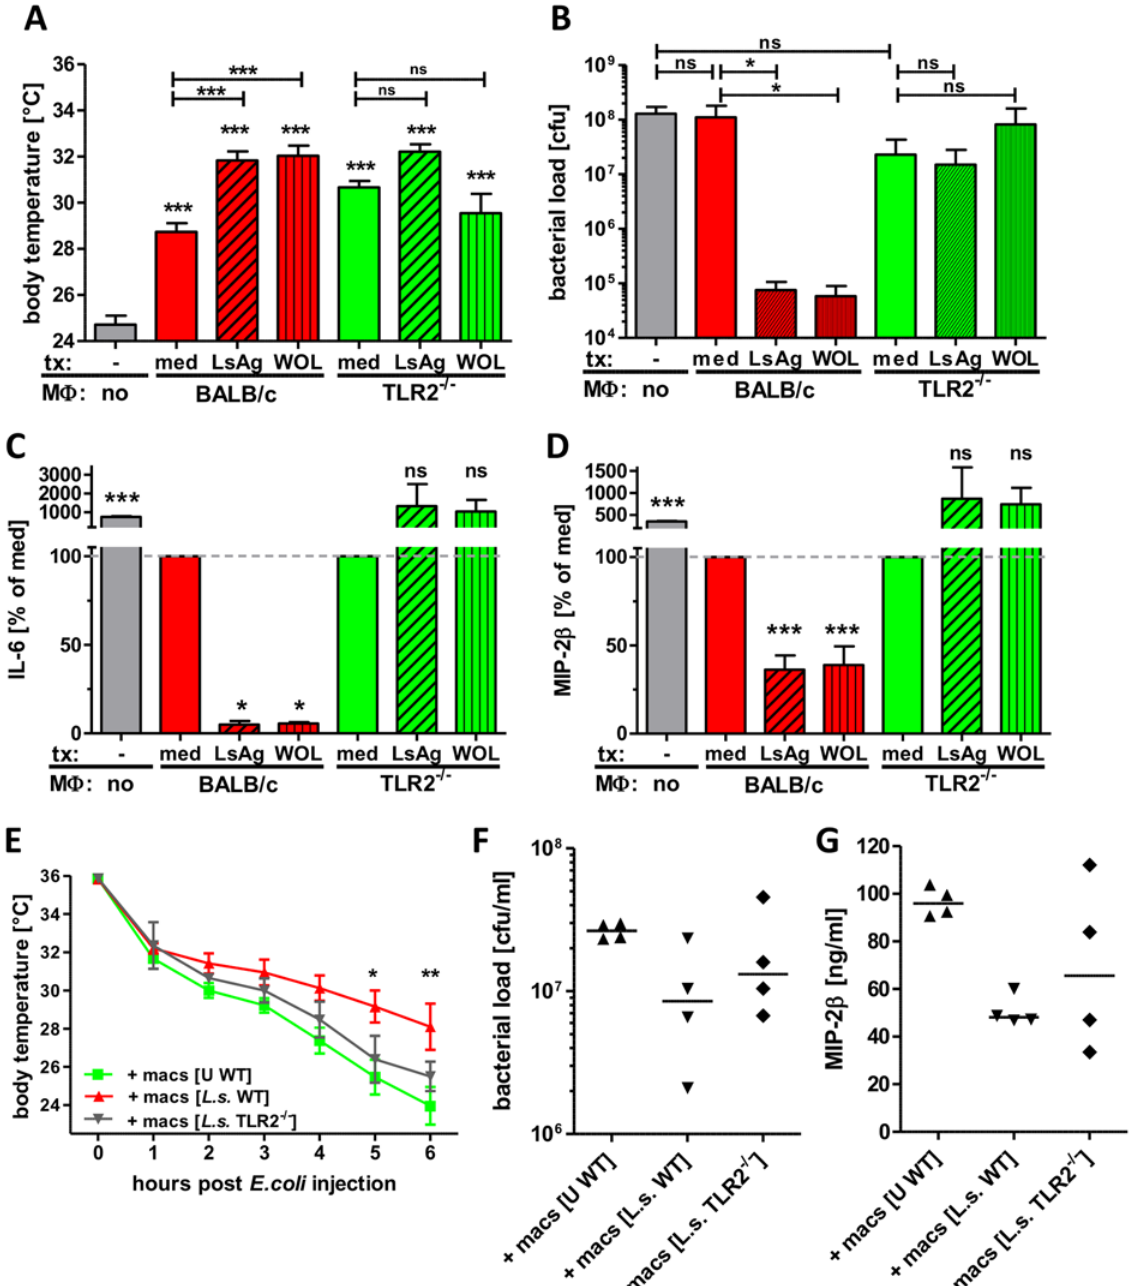
Figure 9. Transfer of primed macrophages improves E. coli -induced sepsis. Macrophages derived from Thioglycollate-treated BALB/c or TLR2 -/- mice were pre-treated in vitro with LsAg, Wolbachia or medium for 24 hours and subsequently transferred into na ï ve recipient wild type mice (n = 6/group). 12 hours after transfer sepsis was induced by i.p. E. coli injection. Body temperature ( A ), peritoneal bacterial loads ( B ) and serum IL-6 ( C ) and MIP-2 β ( D ) were measured six hours after E. coli challenge. In a separate experiment wild type (WT) mice received peritoneal macrophages from either uninfected (U) wild type or chronic L. sigmodontis ( L.s. )-infected WT or TLR2-deficient mice 12h before sepsis. Kinetic of body temperature ( E ), peritoneal bacterial loads ( F ) and serum MIP-2 β ( G ) were measured six hours after E. coli challenge. Bar graphs in ( A-D ) show mean + SEM from recipient mice. Statistical significances were determined by 1-way ANOVA followed by Dunn ’ s multiple comparisons test. Data in ( E ) is displayed as mean +/- SEM and was tested for statistical significance by 2-way ANOVA and Bonferroni post-hoc test. Symbols in ( F, G ) show individual values of recipient mice that were tested for statistical significances by 1-way ANOVA followed by Dunn ’ s multiple comparisons test. * p < 0.05; ** p < 0.01; *** p <